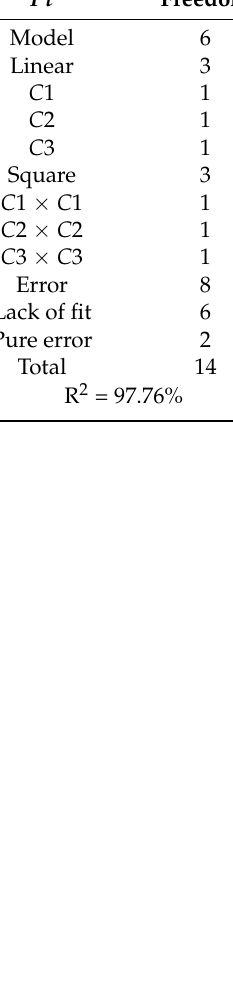
Figure 6. Prediction curves of process parameters.